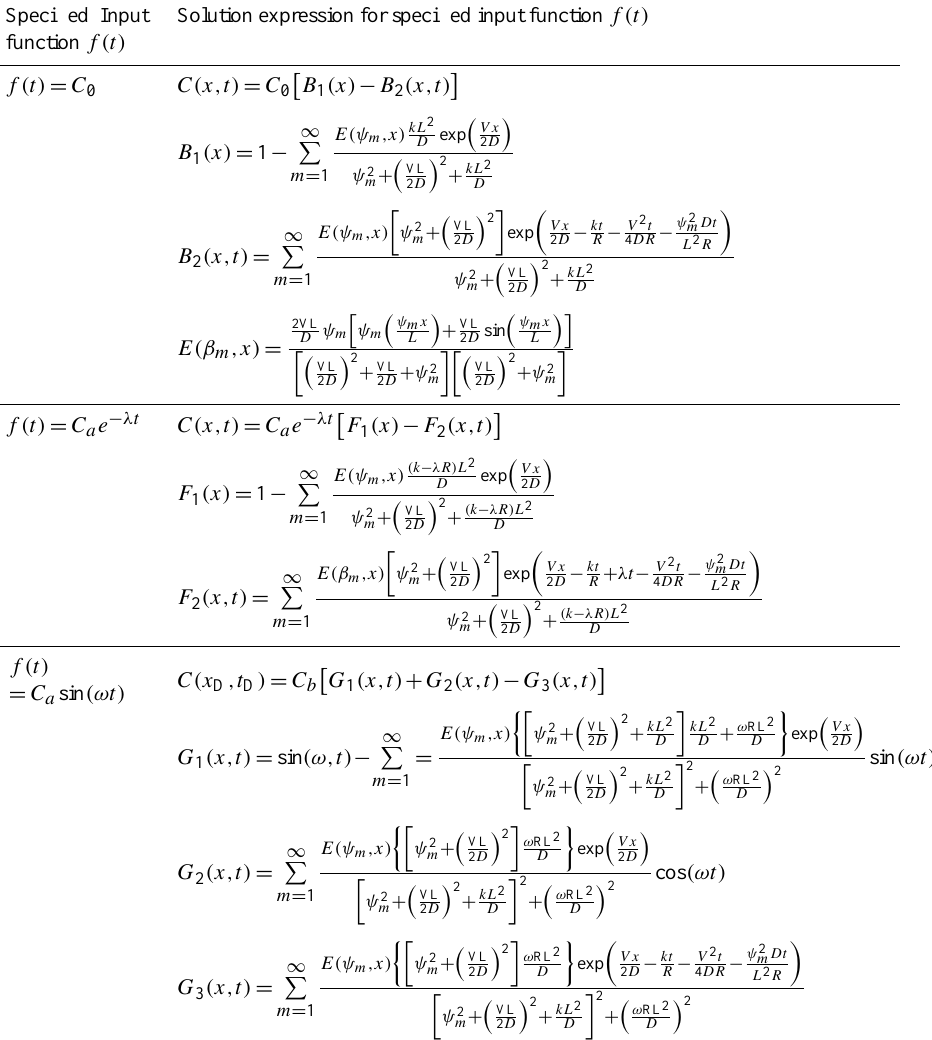
Table 1. Three time-dependent input functions and their corresponding analytical solutions. The solutions for constant and exponential decaying time-dependent input functions are the same as those reported in